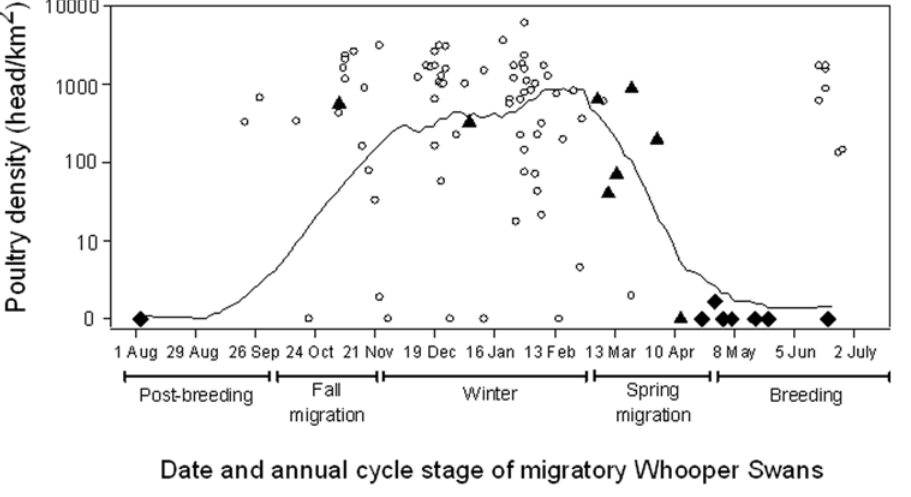
Figure 5. Relationships among migratory whooper swan movements, the timing of H5N1 outbreaks, and the density of poultry in eastern Asia. Solid line represents mean poultry density at whooper swan locations through the annual cycle. Circles (poultry), diamonds (migratory waterbirds), and triangles (wild non-waterbirds) indicate the timing and underlying poultry density at each H5N1 outbreak event. doi:10.1371/journal.pone.0005729.g005 PLoS ONE |